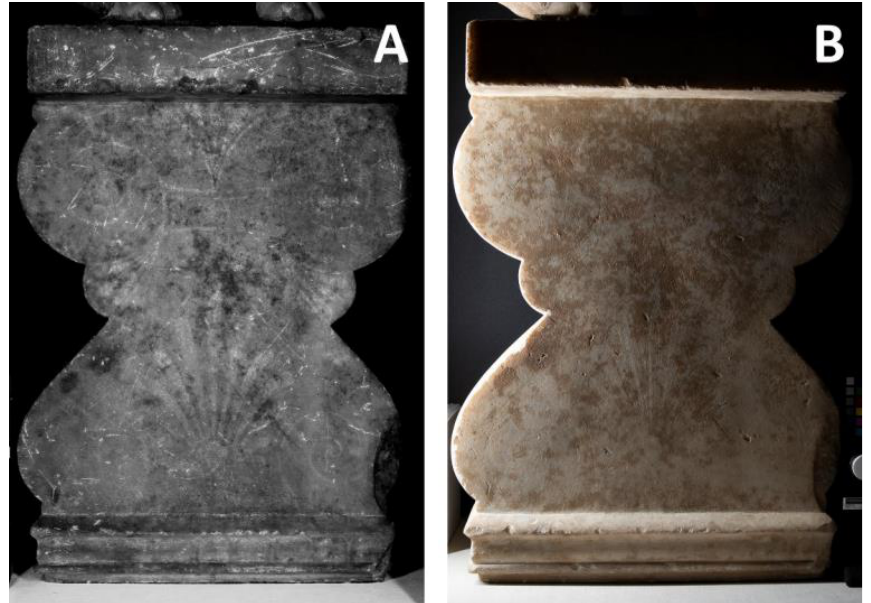
Figure 2. Images of the capital showing the intricate original decoration: ( A ) PS-enhanced UVL; ( B ) raking light.